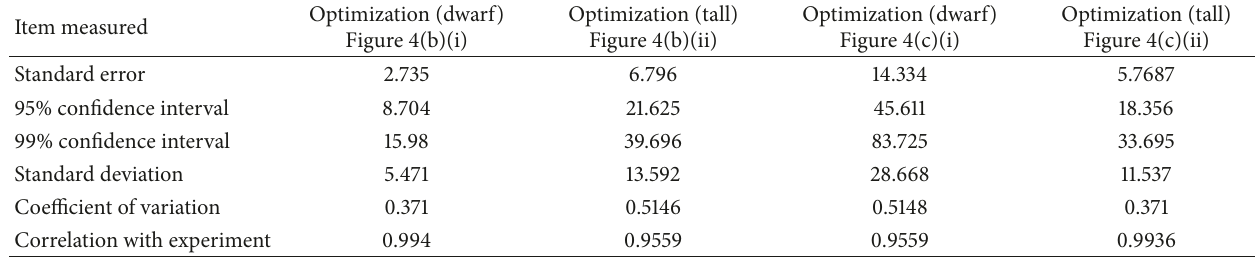
Table 11: Statistical analysis of model.